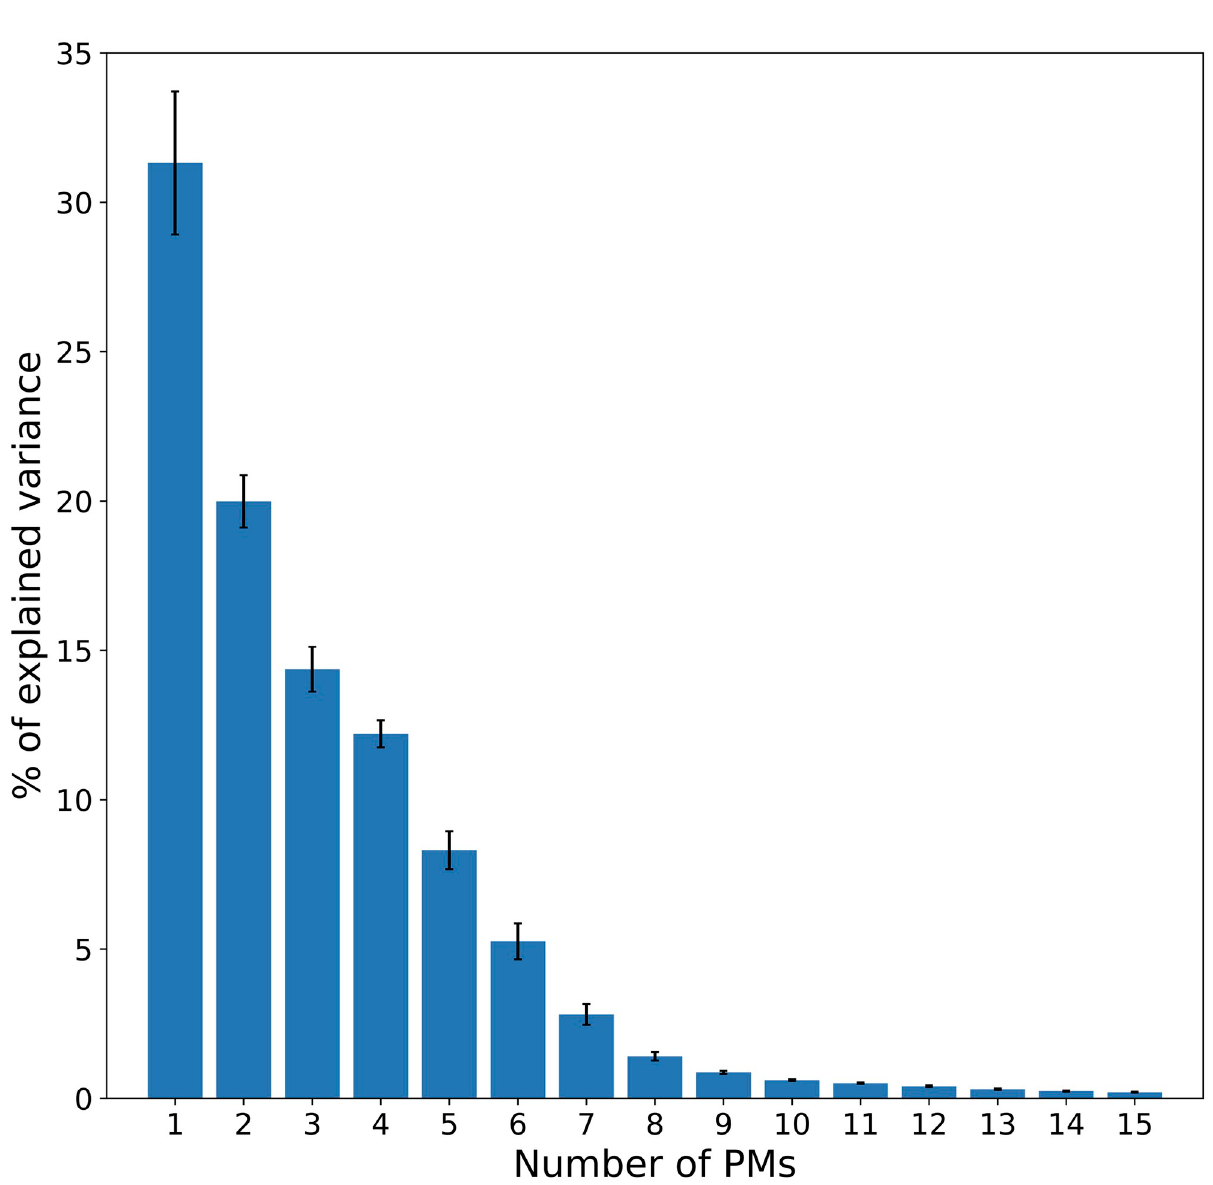
Fig 4. Variance explained by the first 15 individual PMs. Mean was computed across the six signers, error bars indicate standard errors across signers.